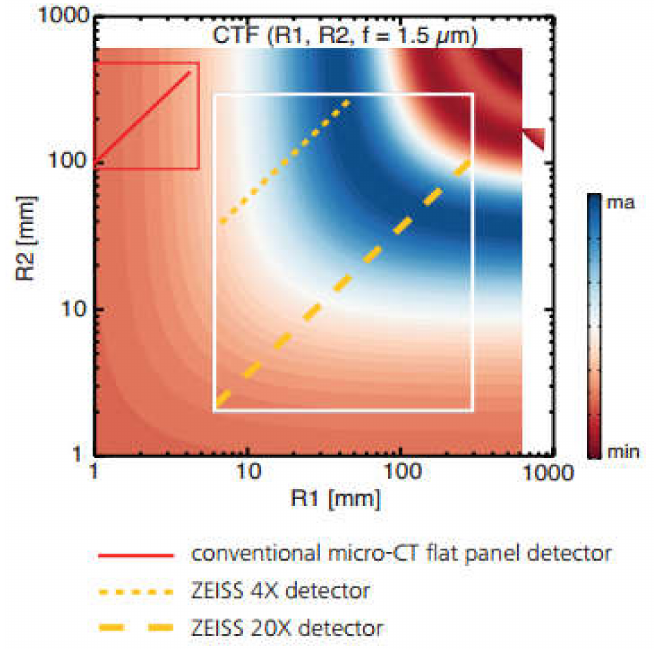
Figure 5. Contrast transfer option (CTF) for a 1.5 µ m feature of 40 kV. The white region is the operation window for Micro-CT devices with optimized phase contrast compared to conventional flat-panel Micro-CT (red box)